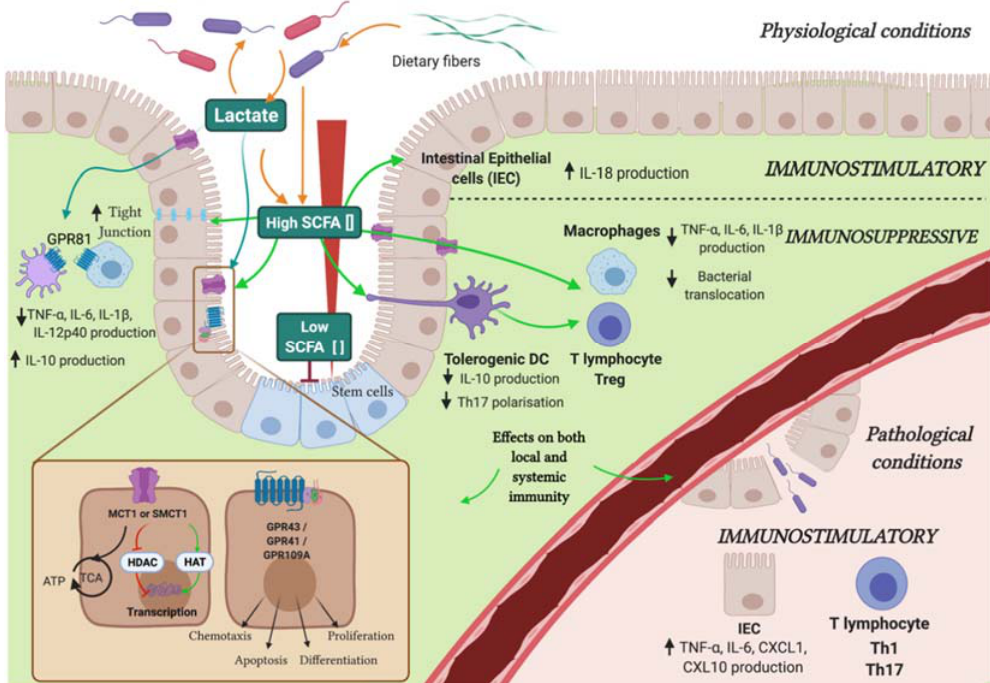
Figure 1. Role of short chain fatty acids (SCFAs) and lactate in immune regulation. SCFAs are produced from bacteria anaerobic fermentation of carbohydrates and dietary fibers. SCFAs have different modes of action on both local and systemic immunity. In physiological conditions, they regulate the intestinal barrier function by upregulation of the expression of the tight junction. Then, they play an important role in T-cell functioning, via regulation of G-protein-coupled receptors (GPR43, GPR41, GPR109A) and inhibition of HDAC (i.e., histone deacetylase). SCFAs regulate dendritic cells (DC) in the differentiation of T-cells, and Treg, Th1, and Th17 generation in different cytokine environments. Moreover, they inhibit the production of proinflammatory cytokines (e.g., TNF- α , IL-6, IL-1 β ) from intestinal macrophages and induce the production of interleukin-18 (IL18) from intestinal epithelial cells (IEC). In pathological conditions, SCFAs activate the production of proinflammatory cytokines and chemokines, such as Tumor Necrosis Factor α (TNF- α ), Interleukin-6 (IL-6), CXCL1, and CXCL10, as well as increasing the production of Th1 and Th17 T lymphocytes. Lactate is a signal molecule of GPR81 and plays an important role in suppressing colonic inflammation.